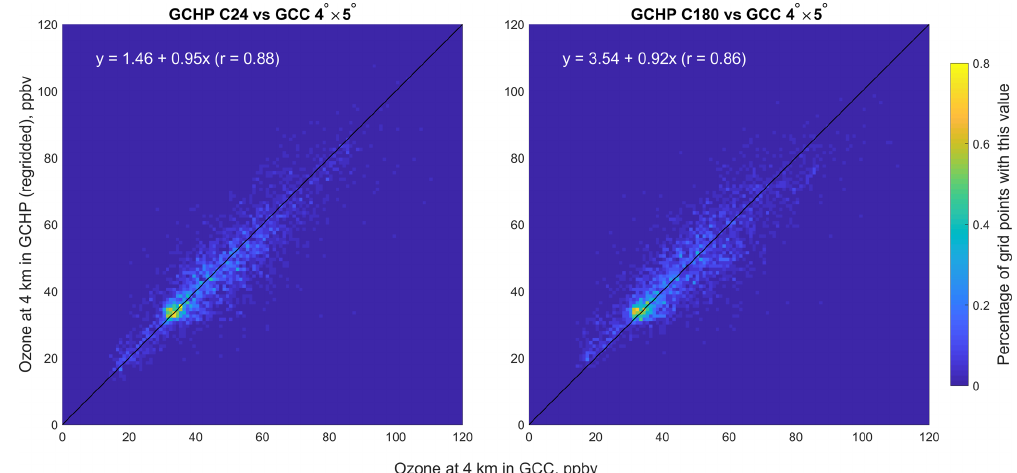
Figure 7. 2-D histograms of simulated ozone at 4km altitude 23:00UTC on 31 July 2016 after 1 month of initialization as calculated by GCC and GCHP. Each panel compares the simulated output from GCHP at a specific resolution with the simulated output from GCC at 4 ◦ × 5 ◦ . Data are binned at a resolution of 1ppbv. GCHP data are conservatively regridded to 4 ◦ × 5 ◦ prior to comparison. Data in the top and bottom two latitude bands are excluded, as GCC averages these points into two “polar